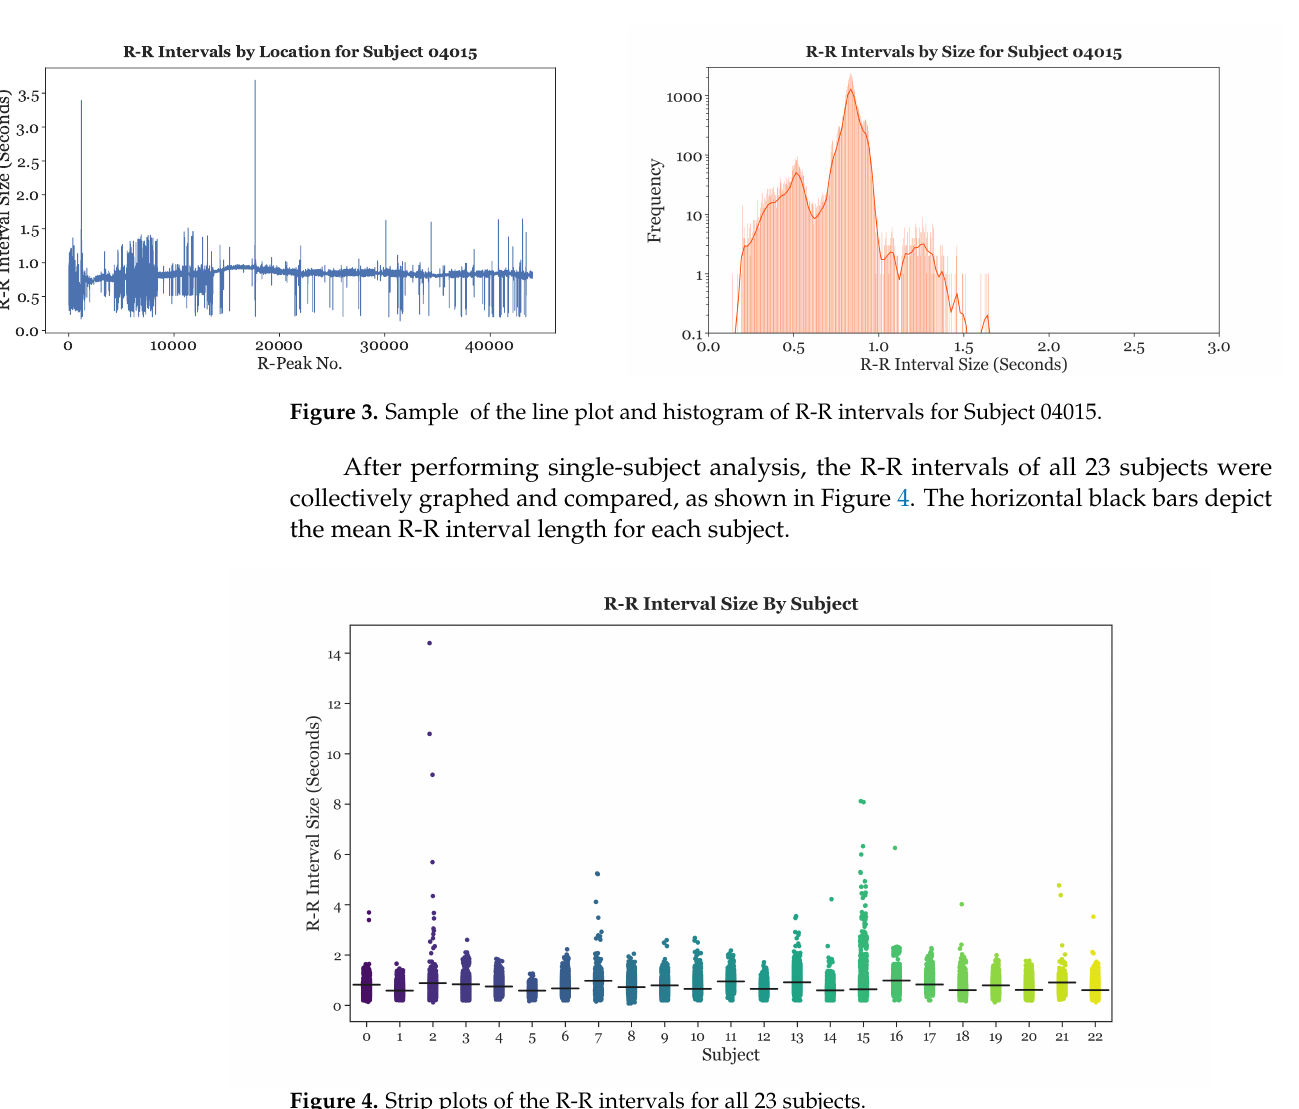
Figure 4. Strip plots of the R-R intervals for all 23